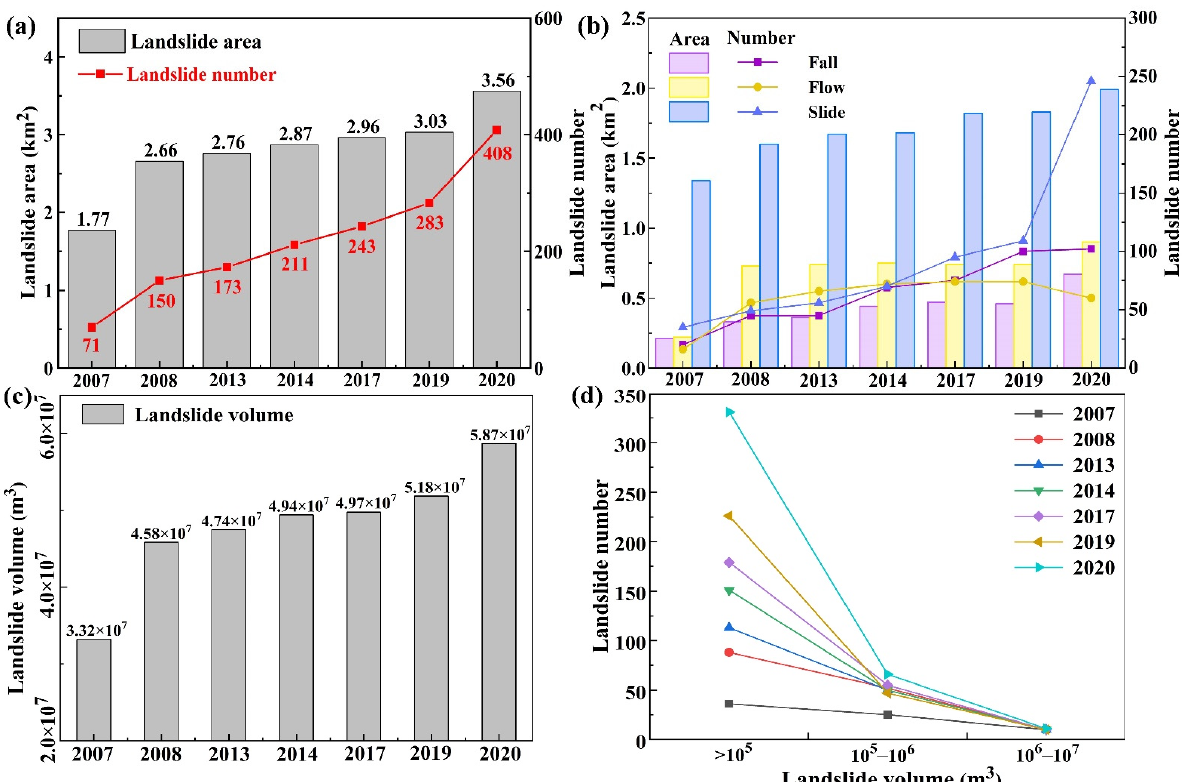
Figure 9. Landslide change trends. ( a ) Changes in the number and area of landslides; ( b ) changes in the number and area of different types of landslides; ( c ) changes in the volume of landslides; ( d ) changes in the number of landslides with different volumes.